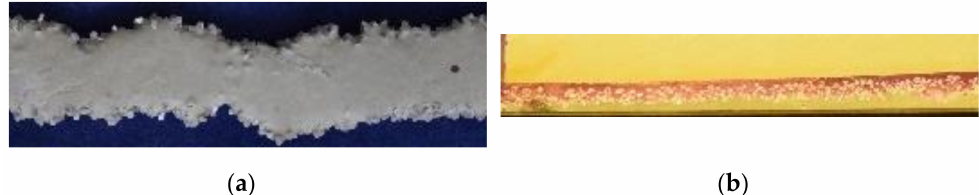
Figure 5. 0.10 m long section of a strand with d 50 = 0.001 m; ( a ) View from top; ( b ) Horizontal view on the lengthwise cross section of a resin-coated strand which is sprayed with phenolphthalein.